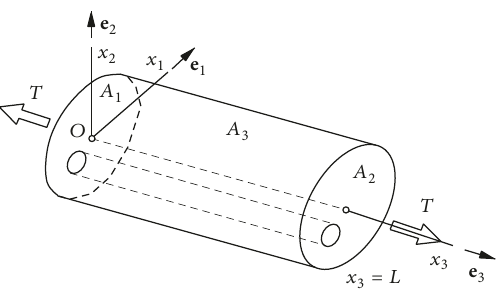
Figure 1: Torsion of a monoclinic piezoelectric